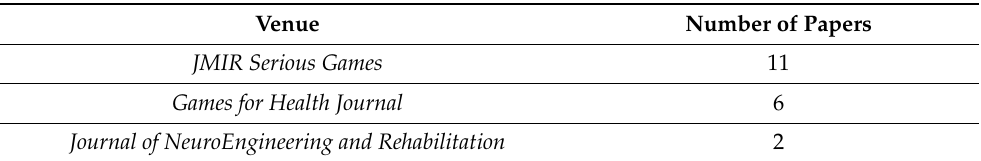
Table 4. Distribution of papers by venue of publication (more than one